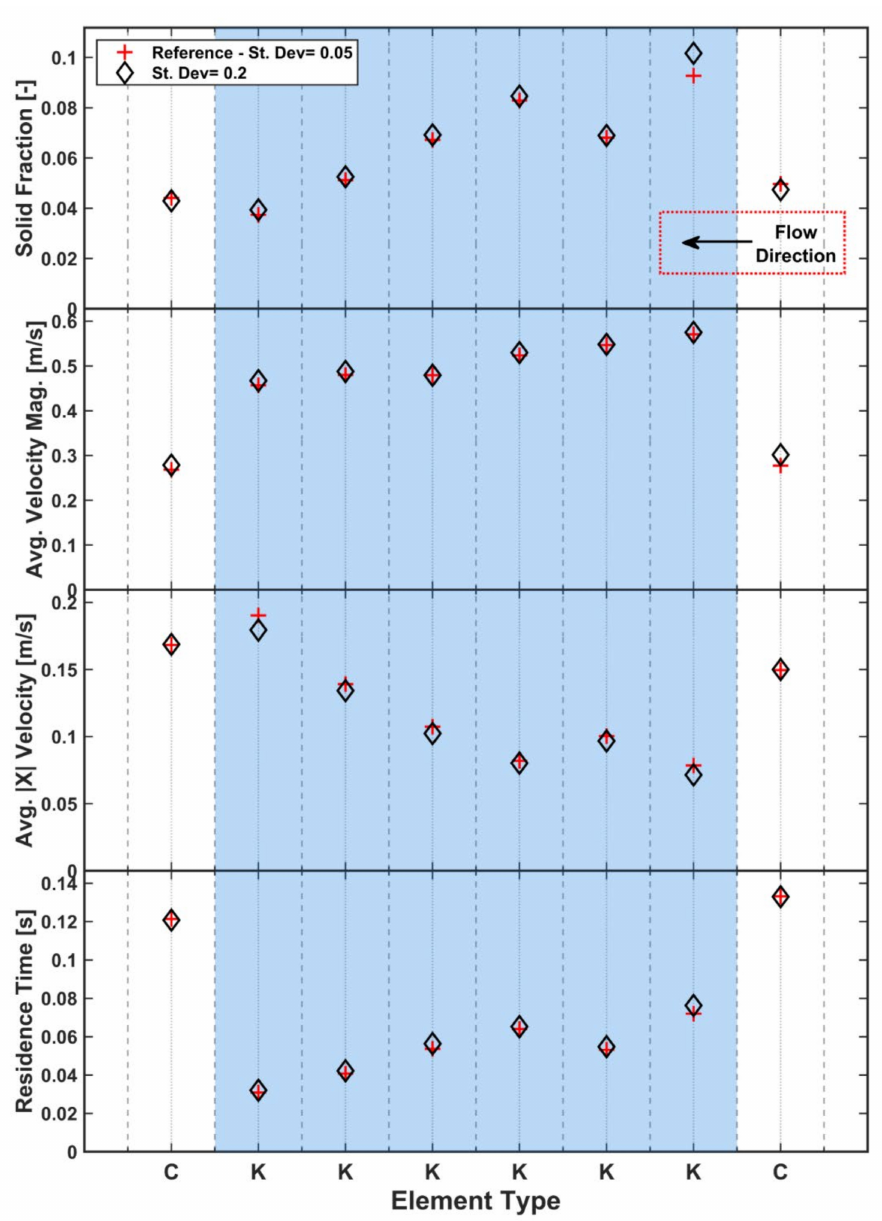
Figure 12. Effect of particle size distribution on solid fraction, velocity and residence